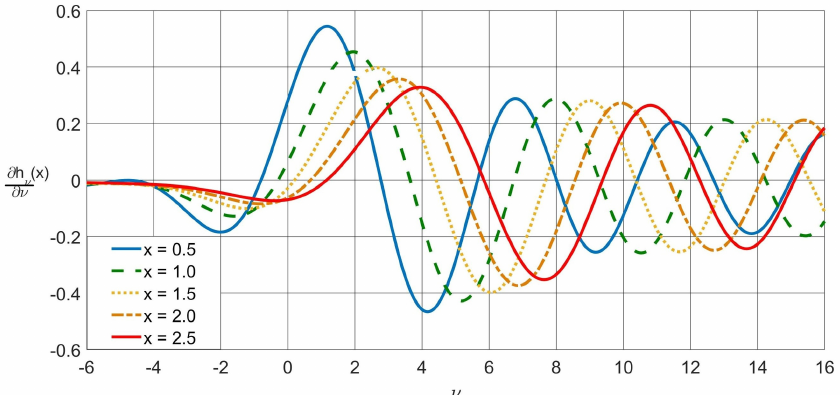
Figure 11. First derivatives of the Havelock functions with respect to the order at fixed positive values of argument x .